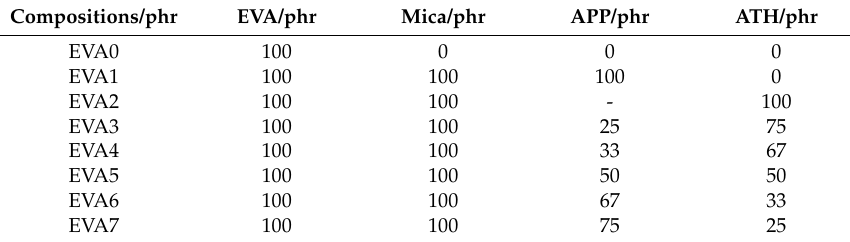
Table 2. Formulations of ceramifiable EVA composites. a